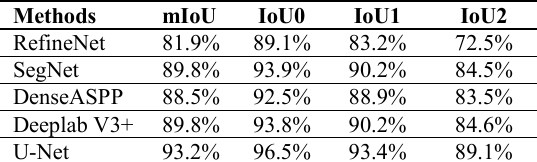
Table 3 . Performance comparison on the test dataset.